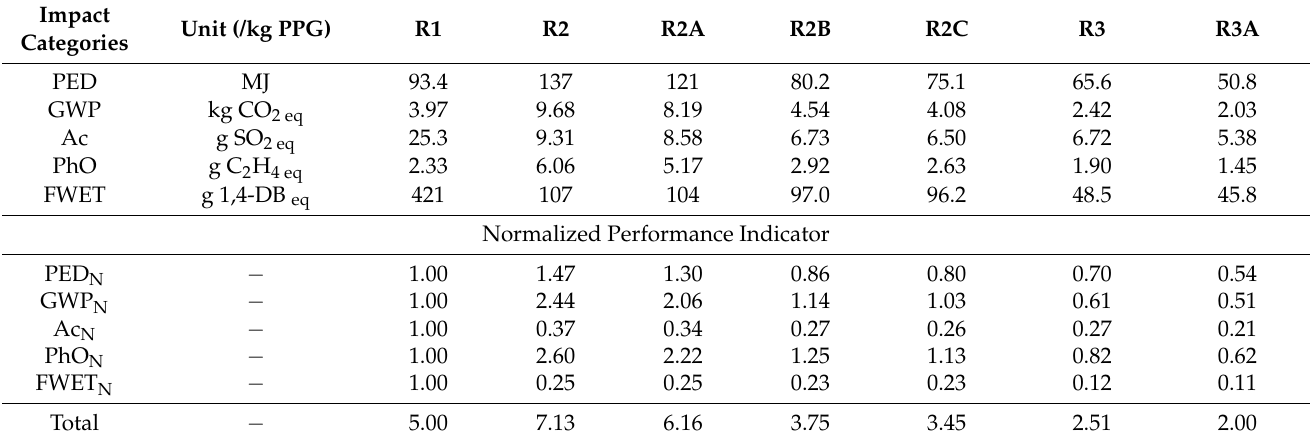
Table 7. Environmental performance improvement proposal effects on the alternative PPG synthesis routes. Impact